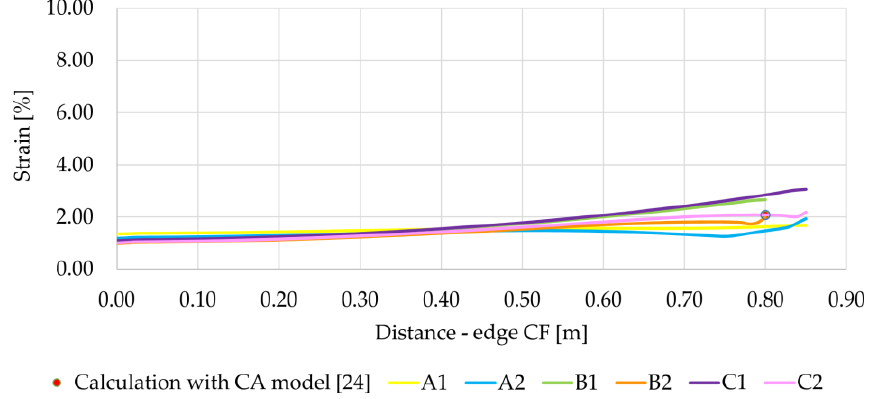
Figure 13. Reinforcement strain at the edge CF depending on the analyzed variant, J = 1615 kN/m. When analyzing graphs of membrane strains along diagonal DP (Figure 14), a much bigger difference in the value of strain at the edge of the column can be seen, depending on the geometric model adopted. In this case, the highest strains at the edge of the column were obtained for the variants A1 and A2, while the strains for the variant A1 are over six times greater than the strains for the variant B2, for which the strains at the edge of the column are the smallest.